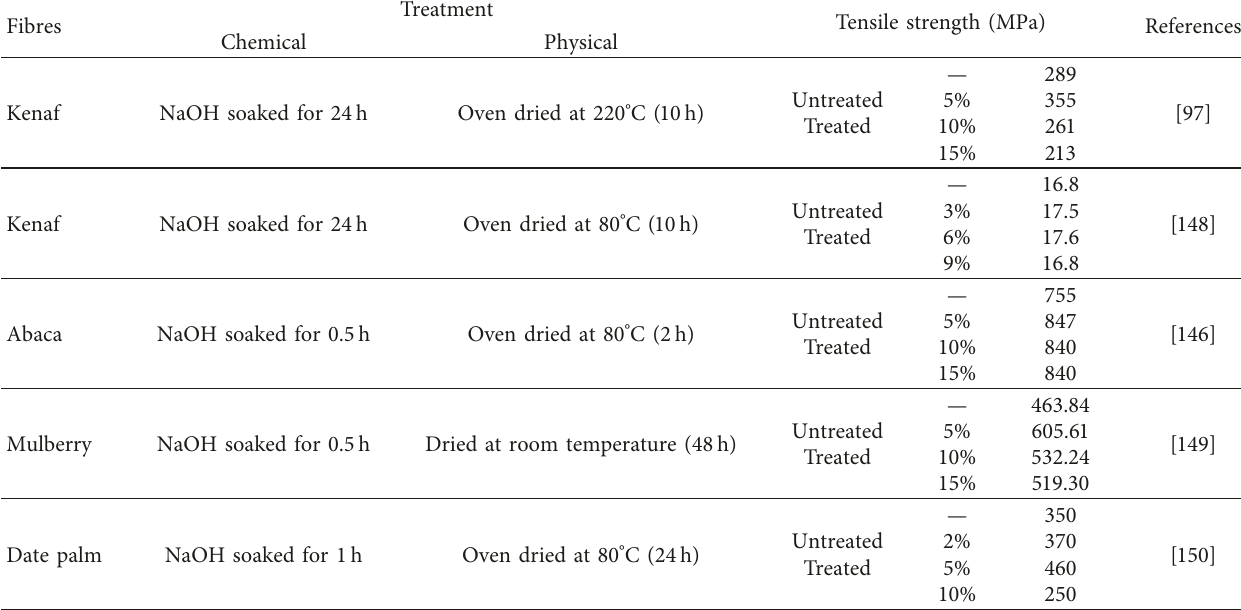
Table 5: Alkali effect on tensile properties of